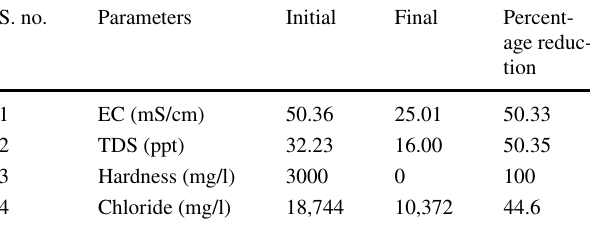
Table 5 Performance of EBCR in removing salts from Sample II S. no.